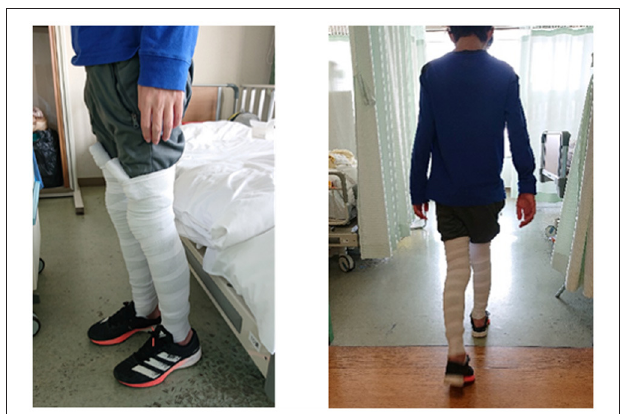
FIGURE 2 | Images of the patient in the standing position and walking with elastic bandages on both lower